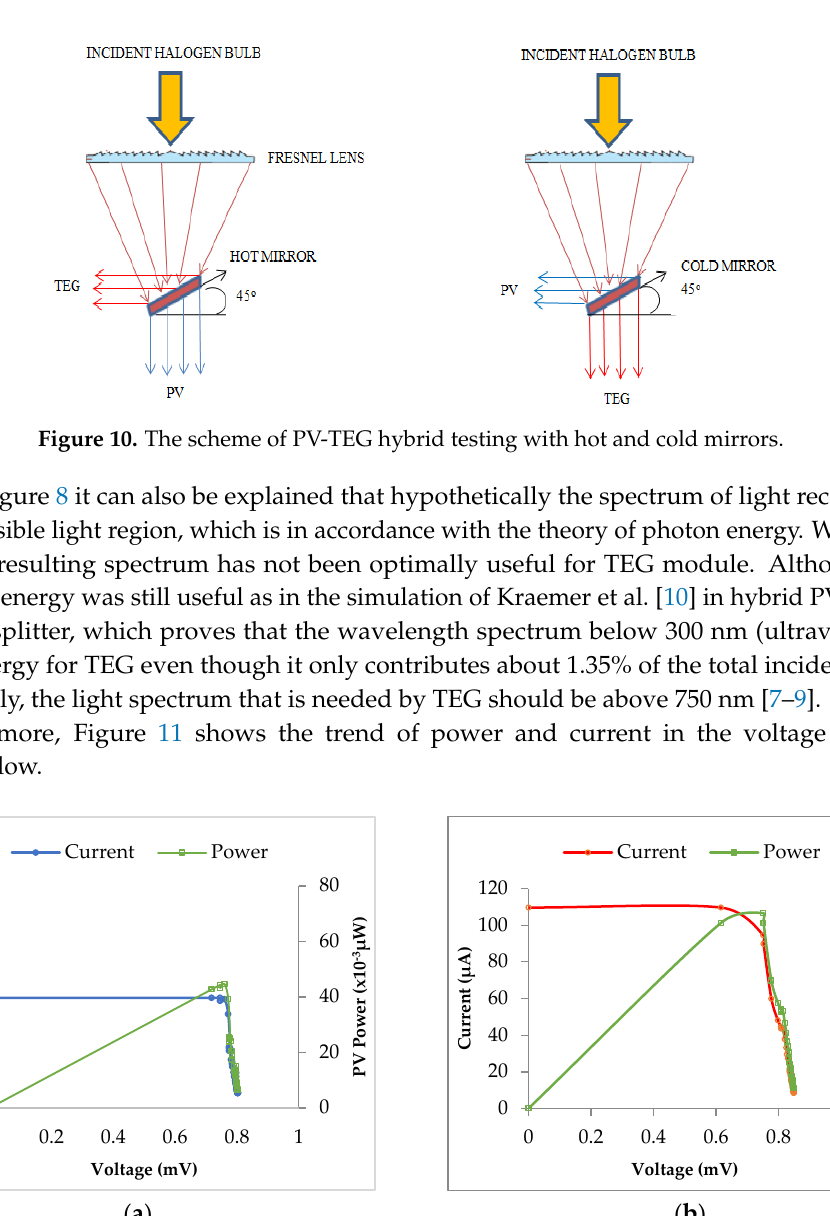
Figure 10. The scheme of PV-TEG hybrid testing with hot and cold mirrors.